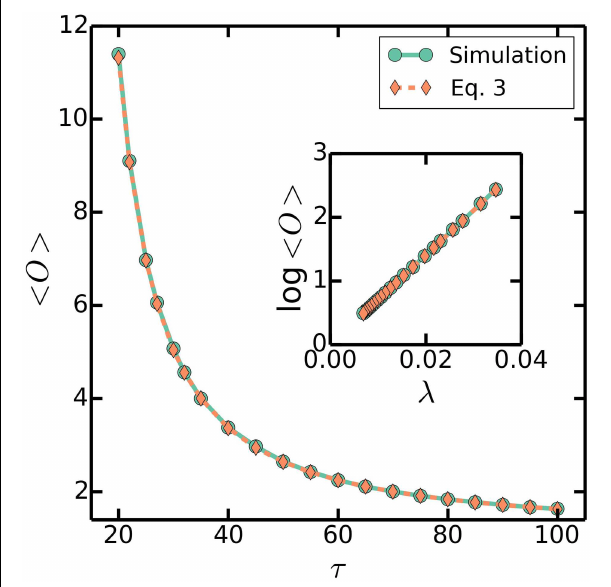
FIGURE 5 | h O i as a function of τ . Simulations are the same as Figure 3 , with a varying τ = 20–100mins, a fixed C + D = 70 mins , and σ τ /τ = 0 . 2 . Dashed line plots (Equation 3). Similarly, inset plots